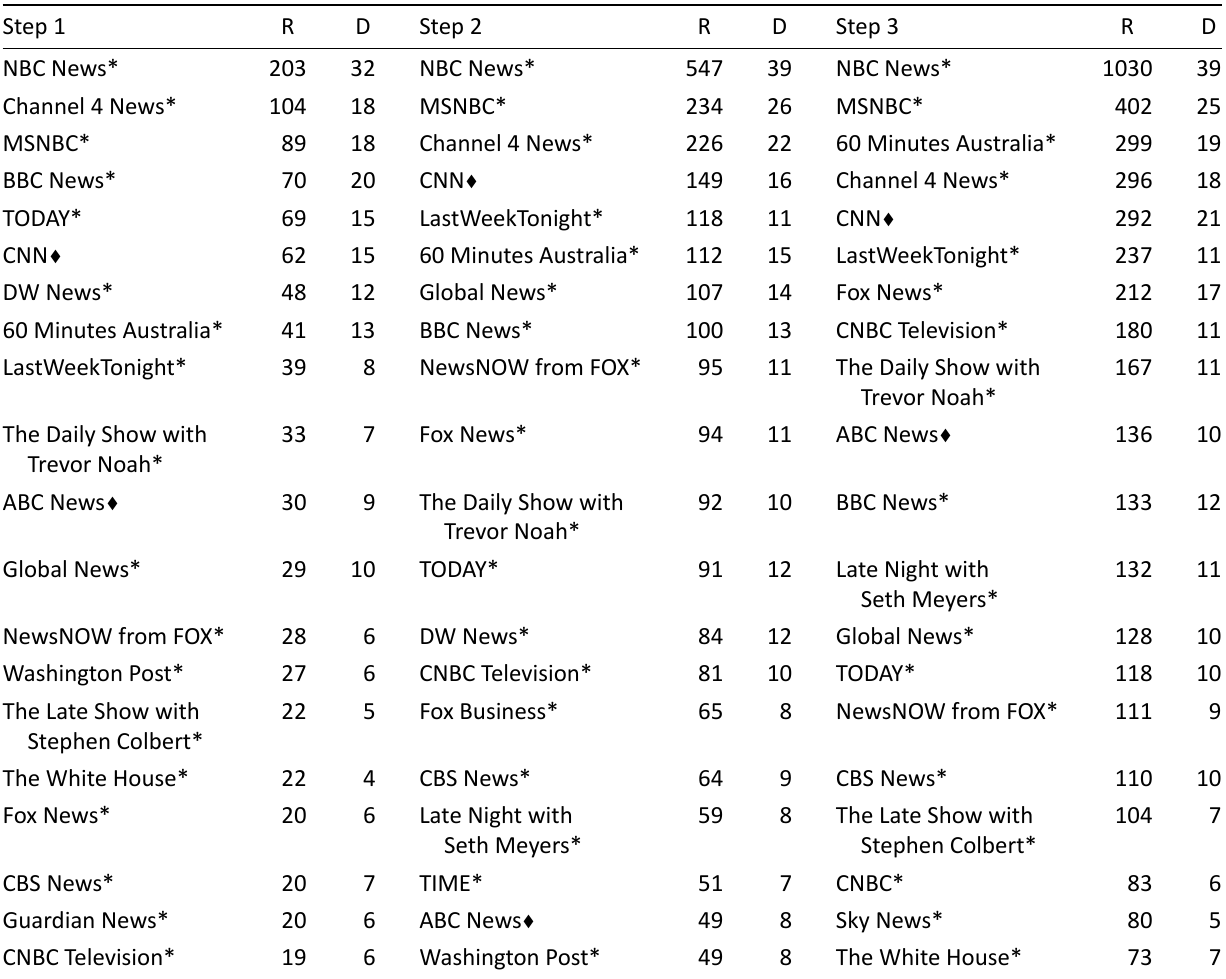
Table 1. Top 20 channels recommended for “coronavirus” at each